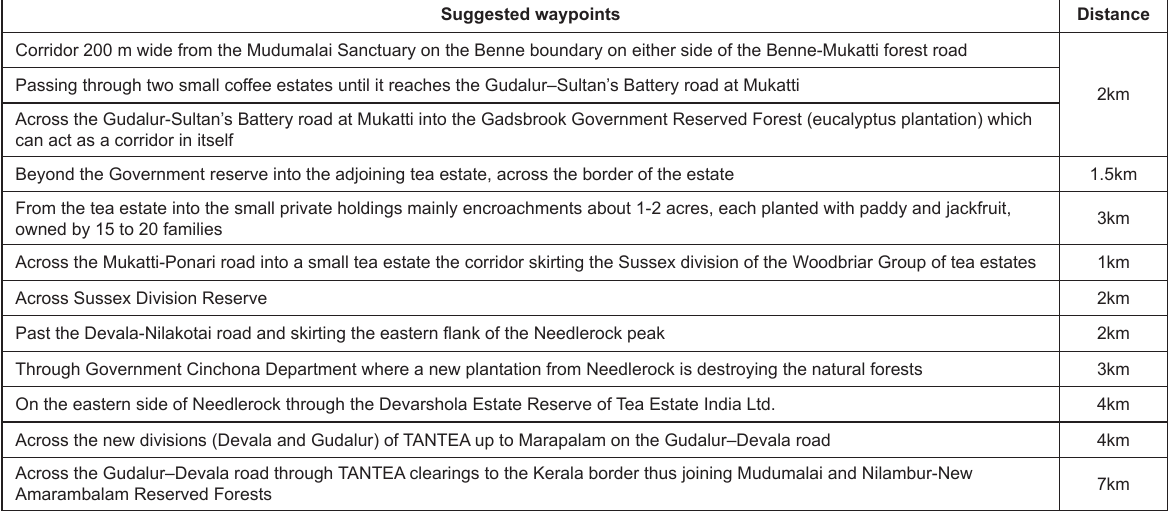
Table 1. The proposed Benne (Mudumalai)-Needlerock-New Amarambalam